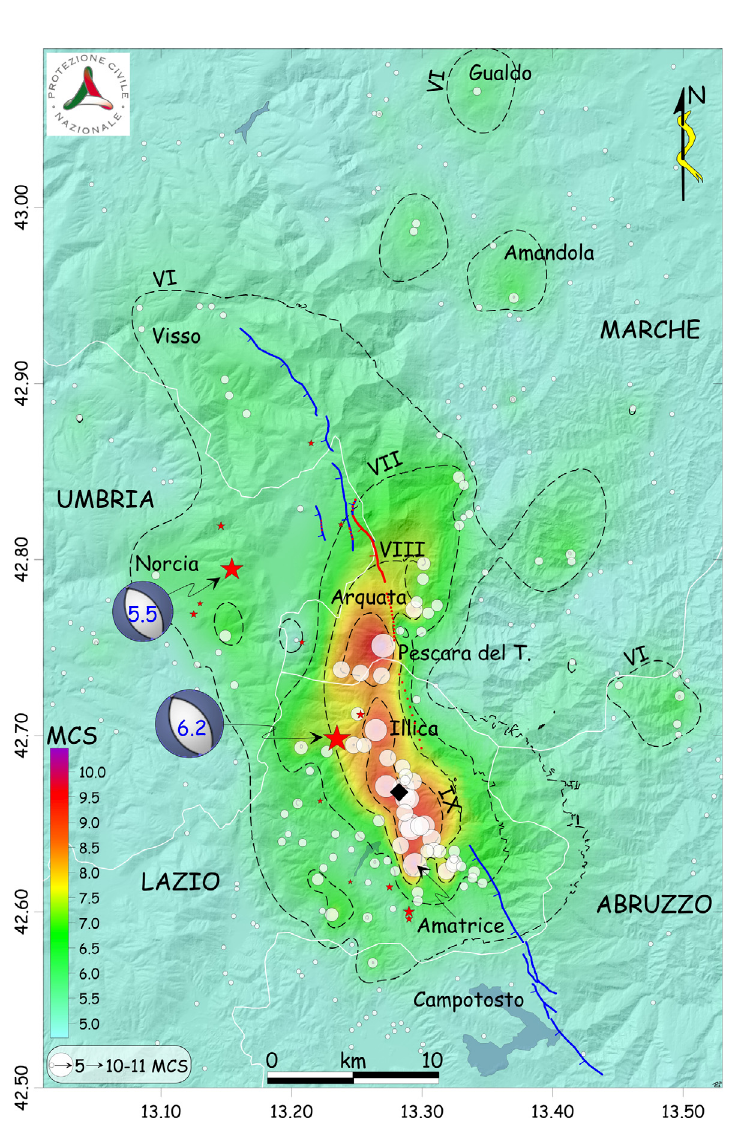
Figure 2. 2016 earthquake MCS intensity distribution. White circles, site intensities (dimension propor- tional to Is). Dotted line, isoseismals from 6 to 9 MCS. Cyan-to-red pattern indicates the areal distrubution of MCS intensity. Red stars, ML>4 events [ISIDe 2016]; black rhomb, macroseismic epicenter. The back- ground is a 20-m-spaced DTM. Blue lines are the active fault segments of the Mount Vettore (north) and Laga Mounts (south) [Galadini and Galli 2003]. Red line (dotted where discontinuous) is the surface break/faulting of the 24 August 2016